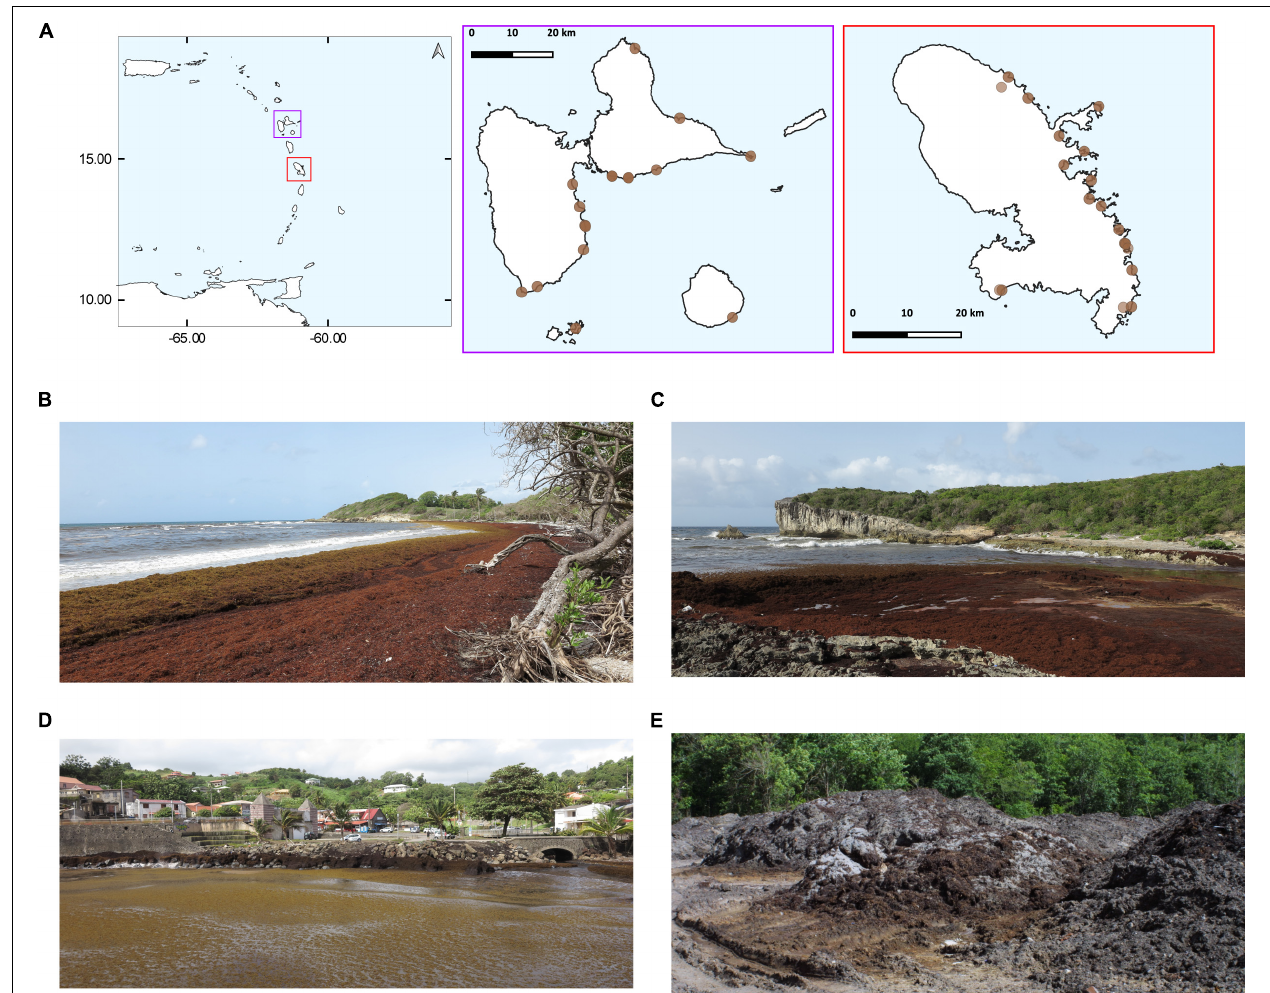
FIGURE 1 | Maps of sampled Sargassum tide sites. The year 2018 corresponded to the biggest tide events ever recorded in the Caribbean region. (A) From left to right, the Caribbean Basin, the Guadeloupe archipelago (violet), and the island of Martinique (red). Due to the proximity of the sampled sites, some circles may overlap. (B–E) Photographs of sampling sites. Sargassum accumulated along the shorelines of Guadeloupe at Saint Félix (B) , and La Porte d’Enfer (C) . In Martinique, Sargassum in the small harbor of Le Marigot city (D) , Sargassum pileup at an inland storage site located in the township of Le Diamant (E)